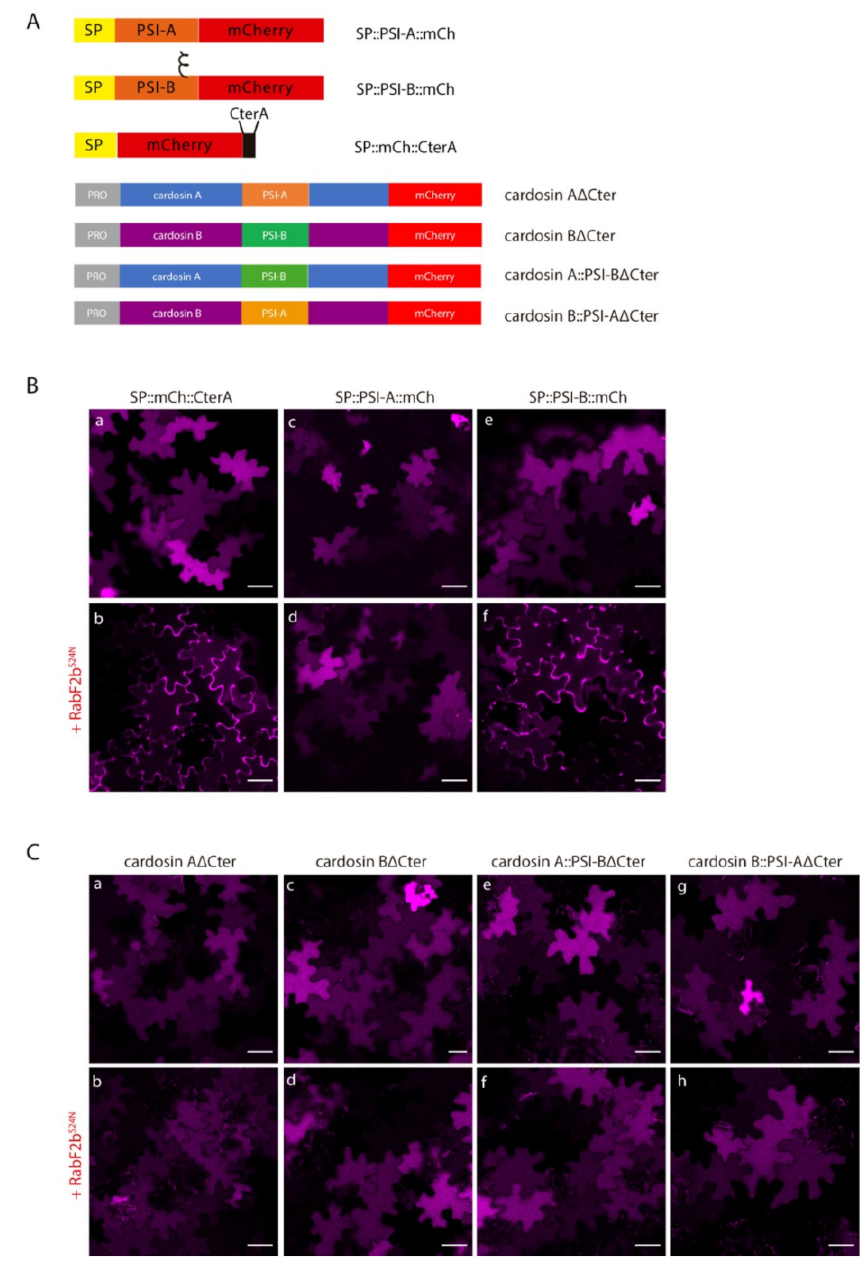
Figure 5. Co-expression of isolated PSIs and cardosin constructs with the dominant negative mutant of RabF2b. ( A ) Schematic representation of the constructs used in this assay. ( B ) Co-expression of SP::PSI-A::mCh (c–d) and SP::PSI-B::mCh (e–f) with the dominant negative mutant RabF2b S24N . SP::mCh::C-terA (a–b) was used as a positive control for the e ffi ciency of the mutant. Note the accumulation in the cell wall in the positive control and SP::PSI-B::mCh, but not for SP::PSI-A::mCh. ( C ) Co-expression of RabF2b S24N with cardosin fusion proteins: (a–b) Cardosin A ∆ Cter, (c–d) Cardosin B ∆ Cter, (e–f)CardosinA::PSIB ∆ Cter, and(g–h)CardosinB::PSIA ∆ Cter. Alltheproteinsareinsensitiveto the blockage of this specific pathway. All observations and images were acquired 3 days post-infiltration. Images were analyzed and processed using ImageJ / Fiji software. Scale bars: 50 µ